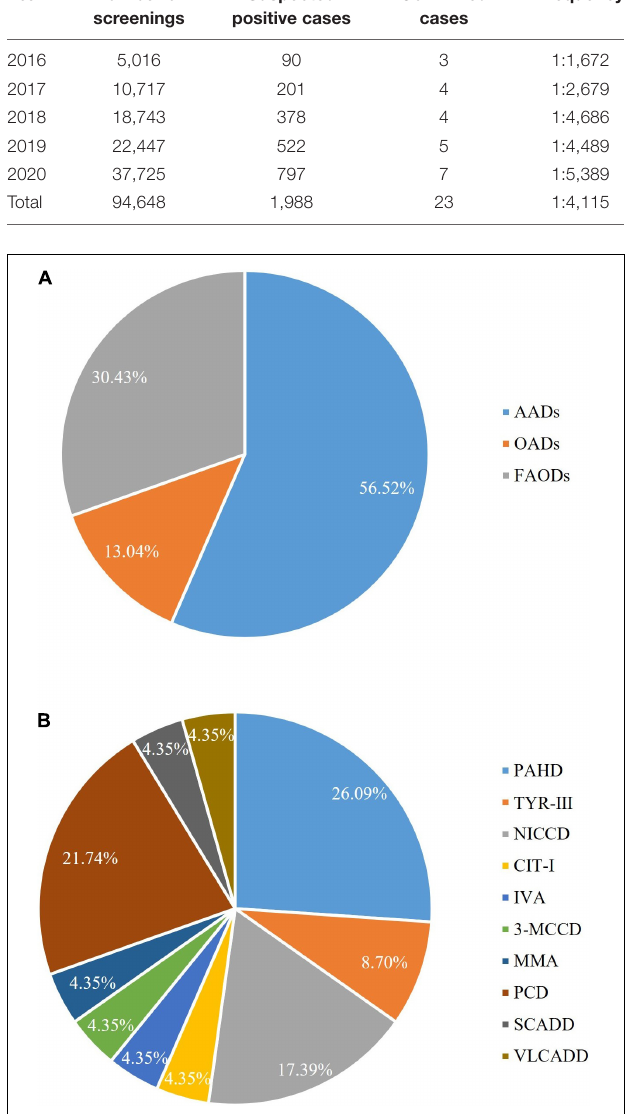
FIGURE 2 | Proportion of inborn errors of metabolism (IEMs) in Shaoyang area from 2016 to 2020.